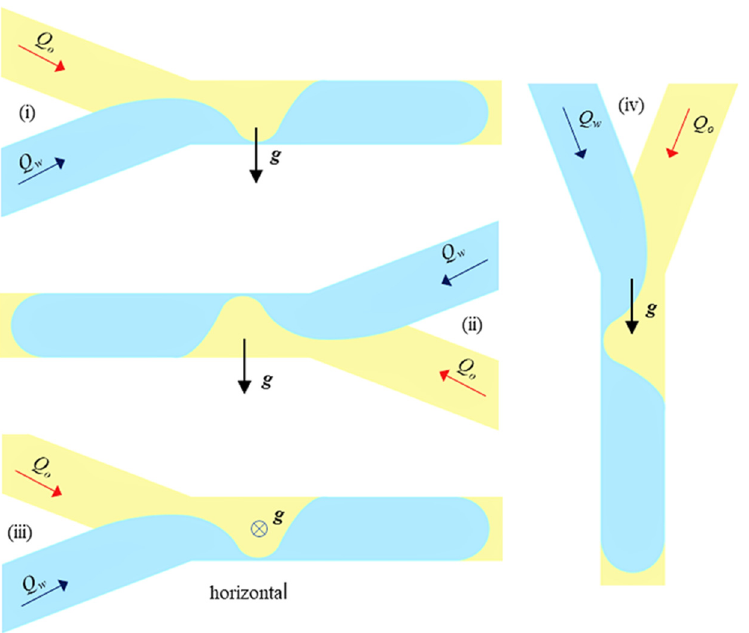
Figure 5. The four tested orientations of the microchannel: ( i ) dense liquid below; ( ii ) dense liquid above; ( iii ) horizontal; ( iv ) vertical ( Q w = water flow rate, Q o = oil flow rate, g = gravitational acceleration). The input flow rates in each branch were in the range of Q (cid:101) [ 500, 900 ] µ L/h, which corresponded to a maximum velocity of 0.2 mm/s (and 0.4 mm/s after bifurcation). There were 25 dripping cases tested with the ratio k = Q w / Q o , with k (cid:101) [ 0.55, 1.8 ] at the viscosity ratio µ = η o / η w , µ = 55. Low flow rates, along with dominant interfacial forces,